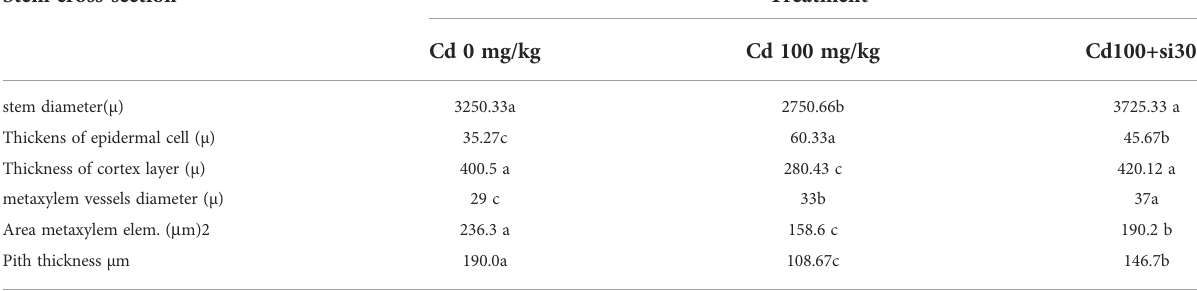
TABLE 7 Effect of foliar application of silicon on pea stem cross-section grown in different concentrations of cadmium. Stem